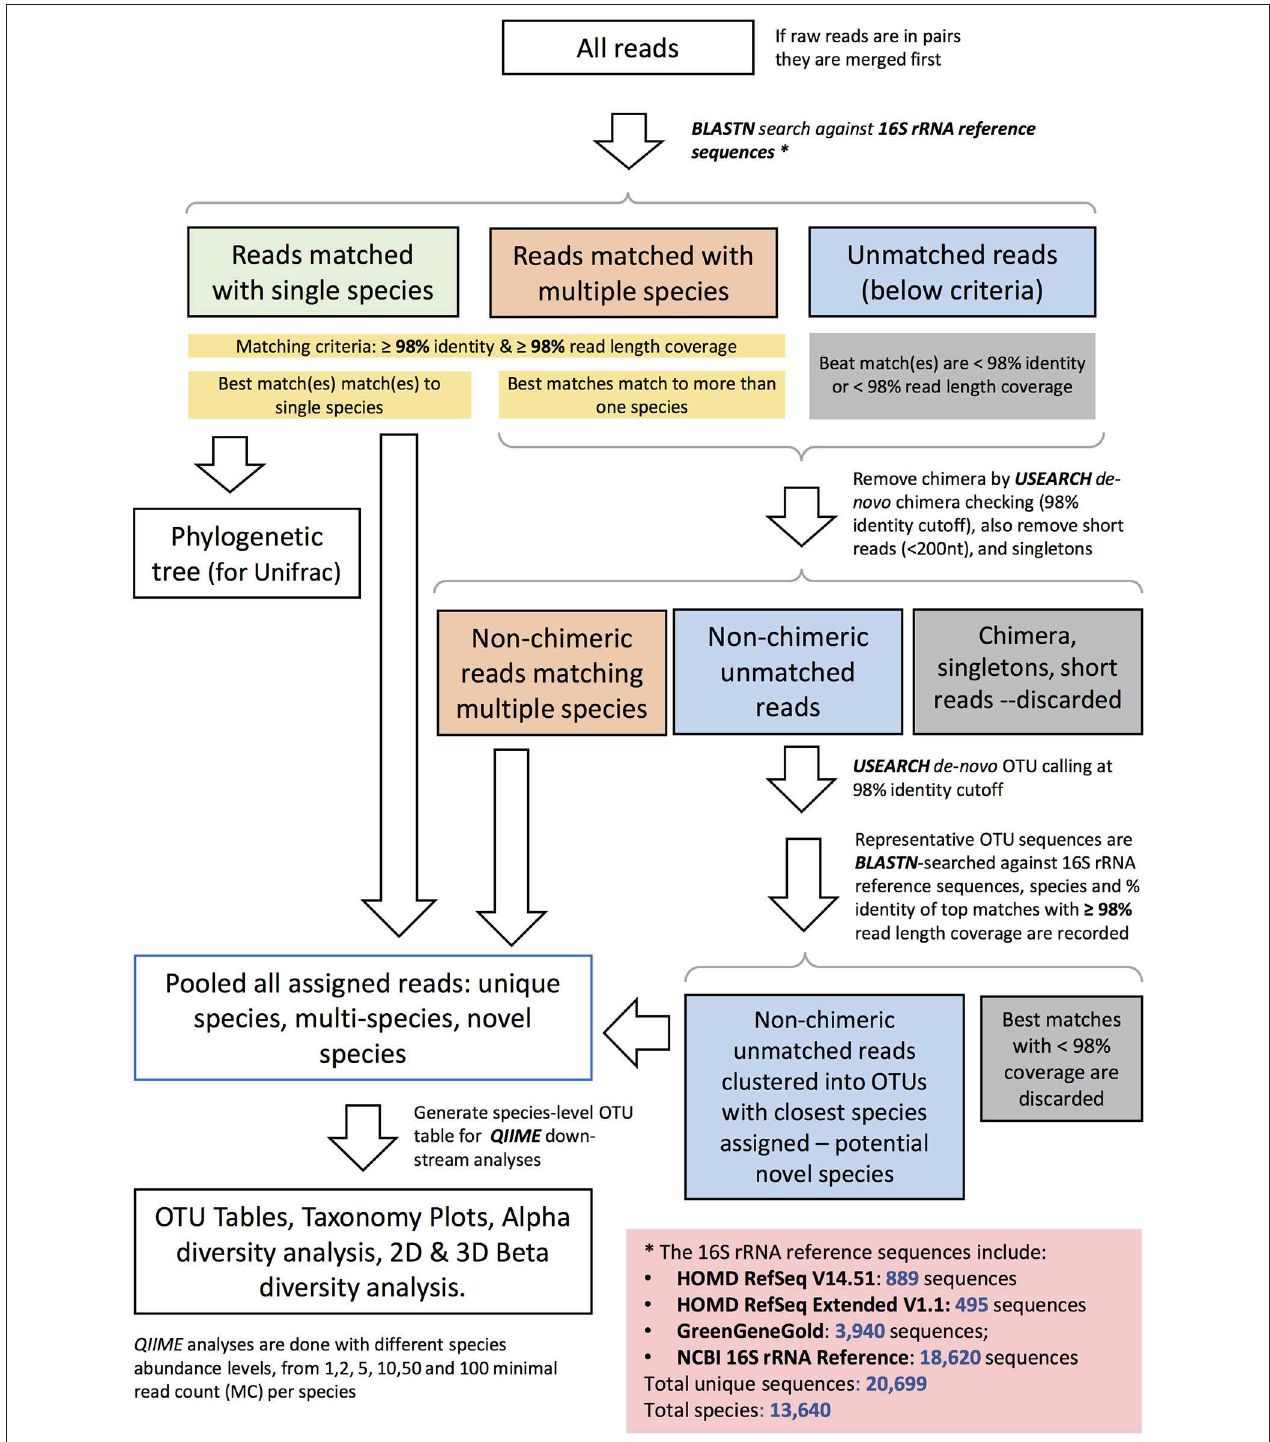
FIGURE 1 | Schematic diagram representing the species–level open reference taxonomy assignment for 16S rRNA Reads. represents the probability of group fidelity. Ideal indicator and Legendre, 2009). The indicator approach measures species are characterized by high exclusivity and fidelity. the predictive ability of community features for a group The function “indVal.g” accounts for unbalanced category (McGeoch and Chown, 1998). The indicator statistic